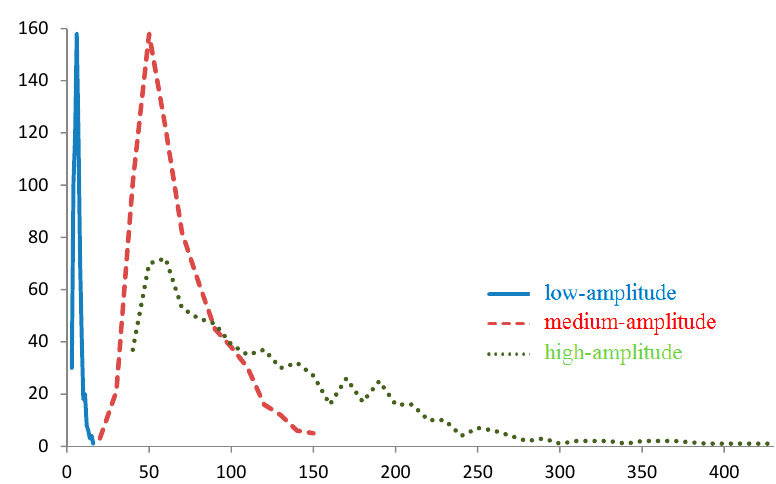
(cid:12) (cid:12) (cid:12) (cid:12) (cid:12) g (cid:12) for regions with low-amplitude, medium-amplitude,